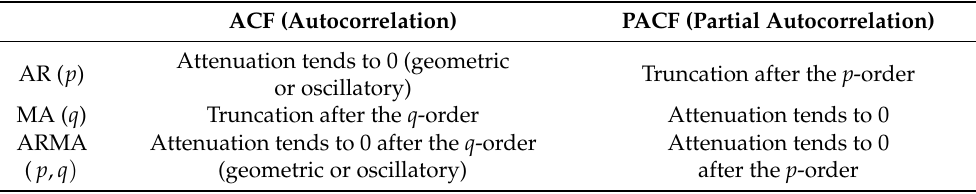
Table 5. ARIMA ( p , d , q ) order determination.